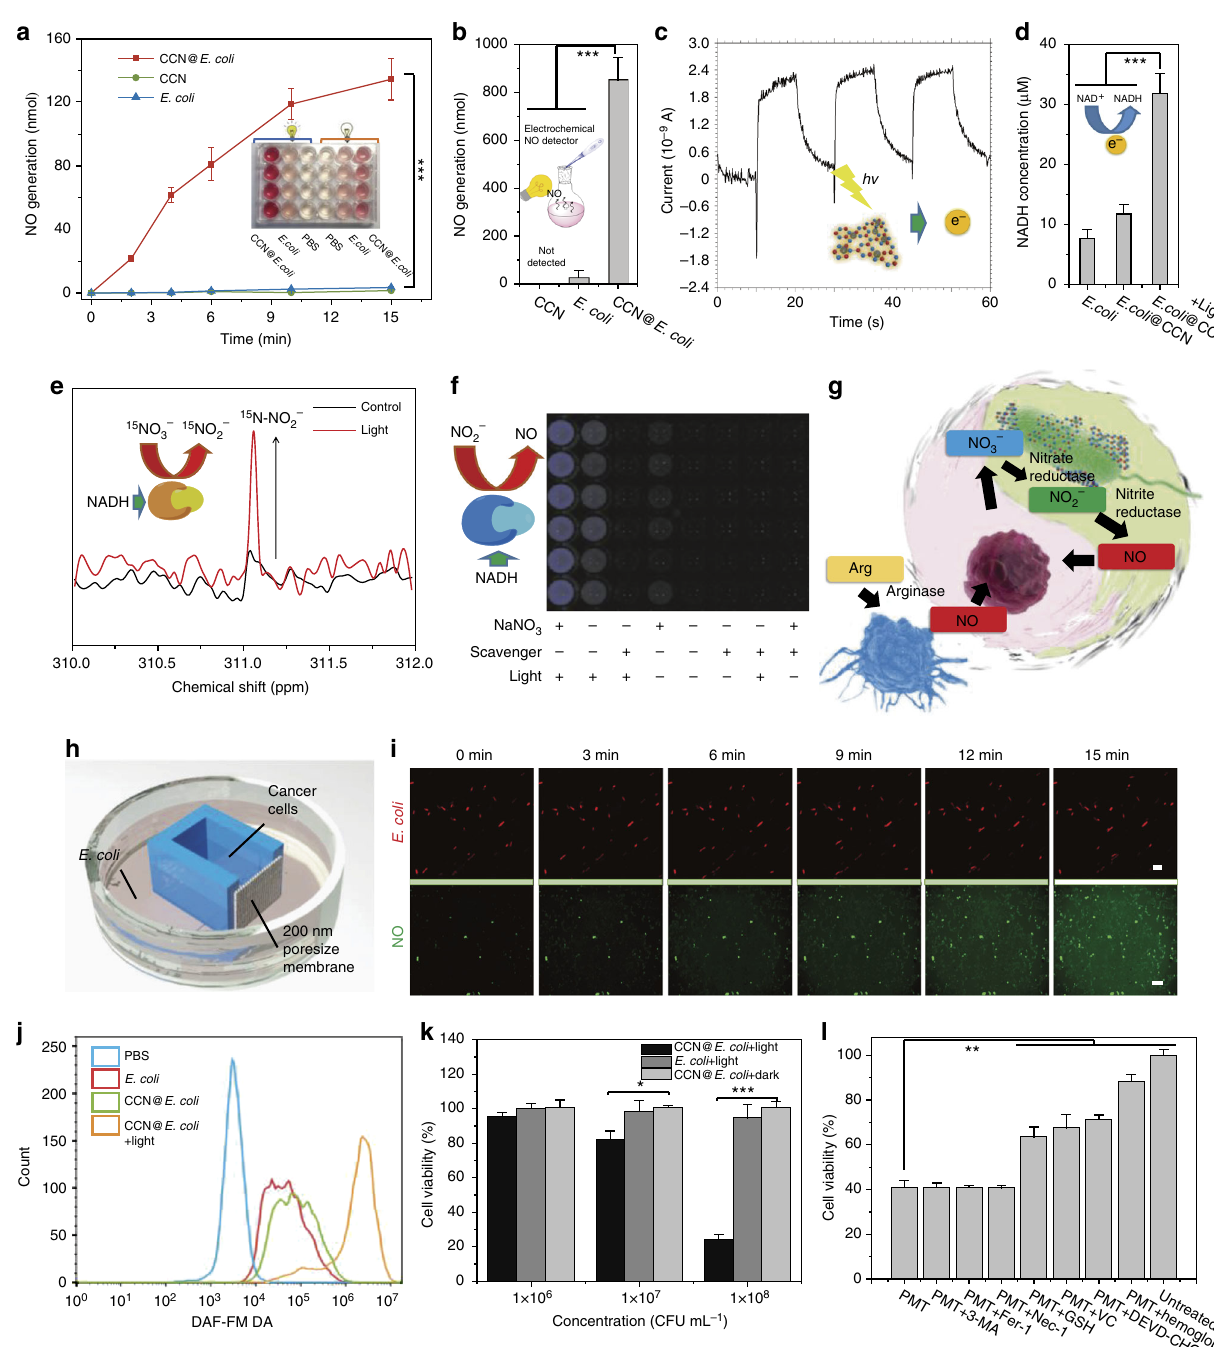
Fig. 2 In vitro study of PMT system. a Griess method for quantitative determining the NO generation of CCN@ E. coli , E. coli (10 9 CFU, 2 mL), and CCN. b Electrochemical method for monitoring the cumulative NO in the gas phase produced by CCN@ E. coli after 15 min of irradiation (10 11 CFU, 5 mL). c Transient photocurrent responses of CCN. d Intracellular NADH level of wide-type E. coli , CCN@ E. coli with or without light irradiation. e 15 N-NMR for monitoring the in situ CCN@ E . coli NO 3 − metabolism with or without light irradiation. The chemical shift of 15 N-pyridine in neutral media was de fi ned as 0 ppm. f Luminol chemiluminiscence assay for qualitative determining NO generation of CCN@ E. coli , E. coli and CCN. g Schematic illustration for the optically controlled NO metabolism close loop. h Schematic diagram of the 3D-printing co-culture system. i Images from the co-culture system time series sequentially observing CCN@ E. coli movement and NO generation (Scale bar: 2 μ m for the fi rst row and 100 μ m for the second row). j Flow cytometry for measuring the intracellular NO concentration of 4T1 cells after various treatment. k Cell viability of 4T1 cells co-cultured with CCN@ E. coli . l Cell viability of 4T1 cells co-cultured with CCN@ E. coli after 3-MA (3-Methyladenine, autophagy inhibitor), Fer-1 (ferrostatin-1, ferroptosis inhibitor), Nec-1 (Necrostatin-1, necroptosis inhibitor), Ac-DEVD-CHO (apoptosis inhibitor), hemoglobin treatment (NO scavenger), glutathione (GSH, ROS trapper), sodium ascorbate (VC, ROS trapper). Signi fi cance between every two groups was calculated using unpaired two-tailed Student ’ s t -test unless otherwise indicated. * P < 0.05, ** P < 0.01, *** P < 0.001. The mean values and S.D. are presented. Data of panels a , b , d , f , j , k , and l are from >4 biological replicates per